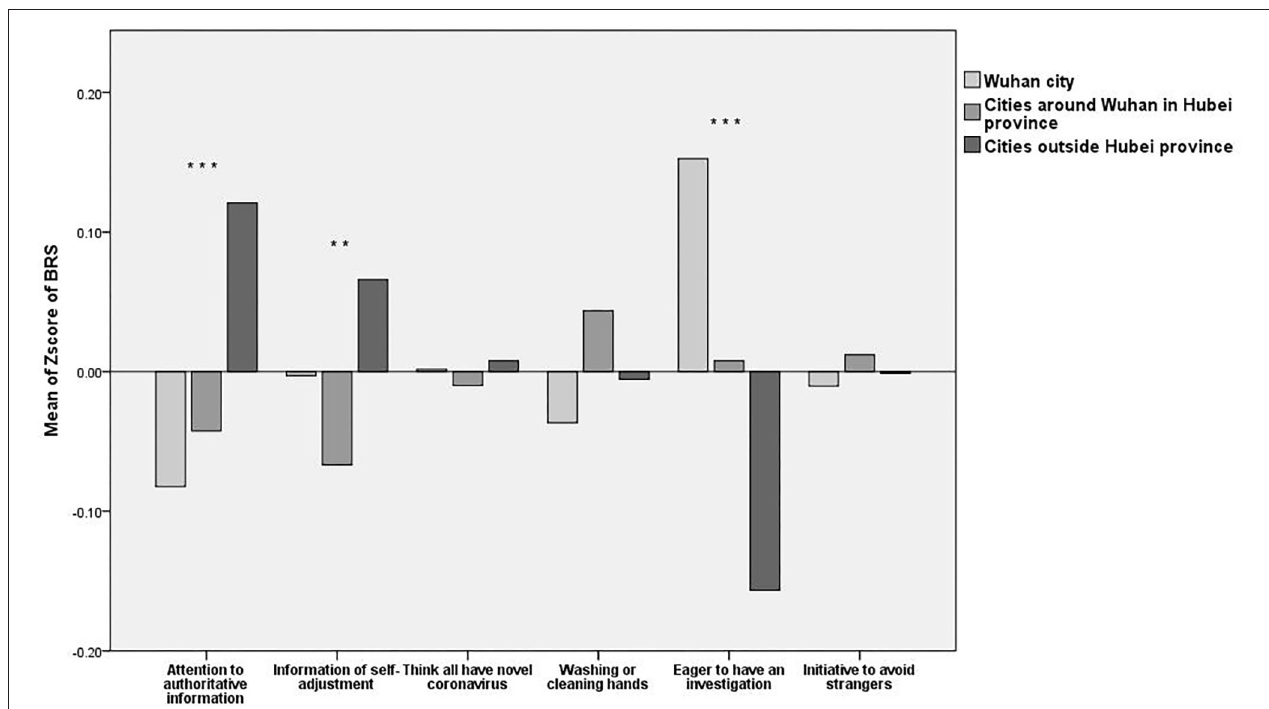
FIGURE 4 | Mean Z-scores of the Behavioral Response subscale (BRS). ** P < 0.01, and *** P <